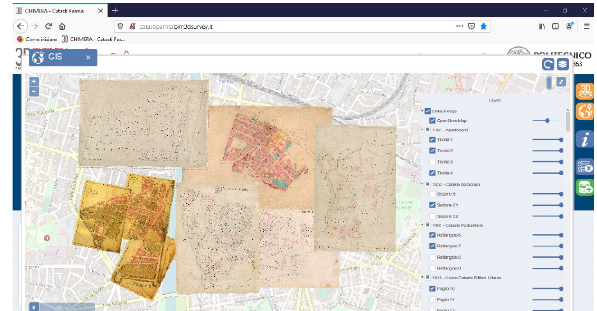
Figure 2. Example of 2D map data visualization within the system. Some layers belonging to Level 0 but referring to different periods are displayed. Each layer can be switched on and off and its transparency can be